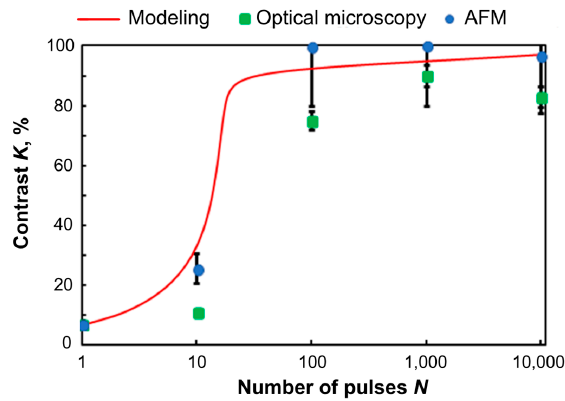
Figure 7. Calculated ( solid line ) and experimentally determined ( points ) dependence of the con- trast of the recorded structures on the number of pulses. of the recorded structures on the number of